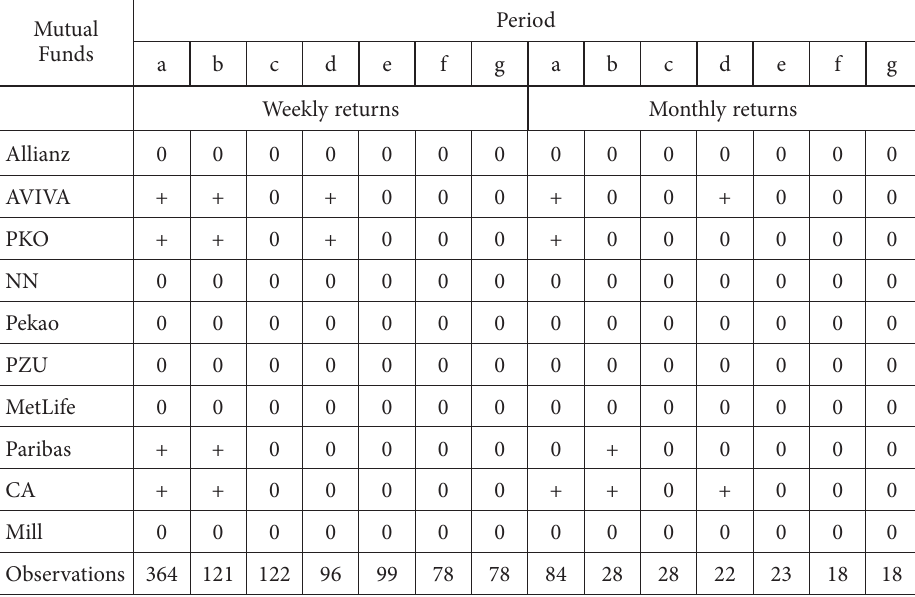
Table 5. Decisions based on statistics (1) for mutual funds expected weekly and monthly returns (source: own